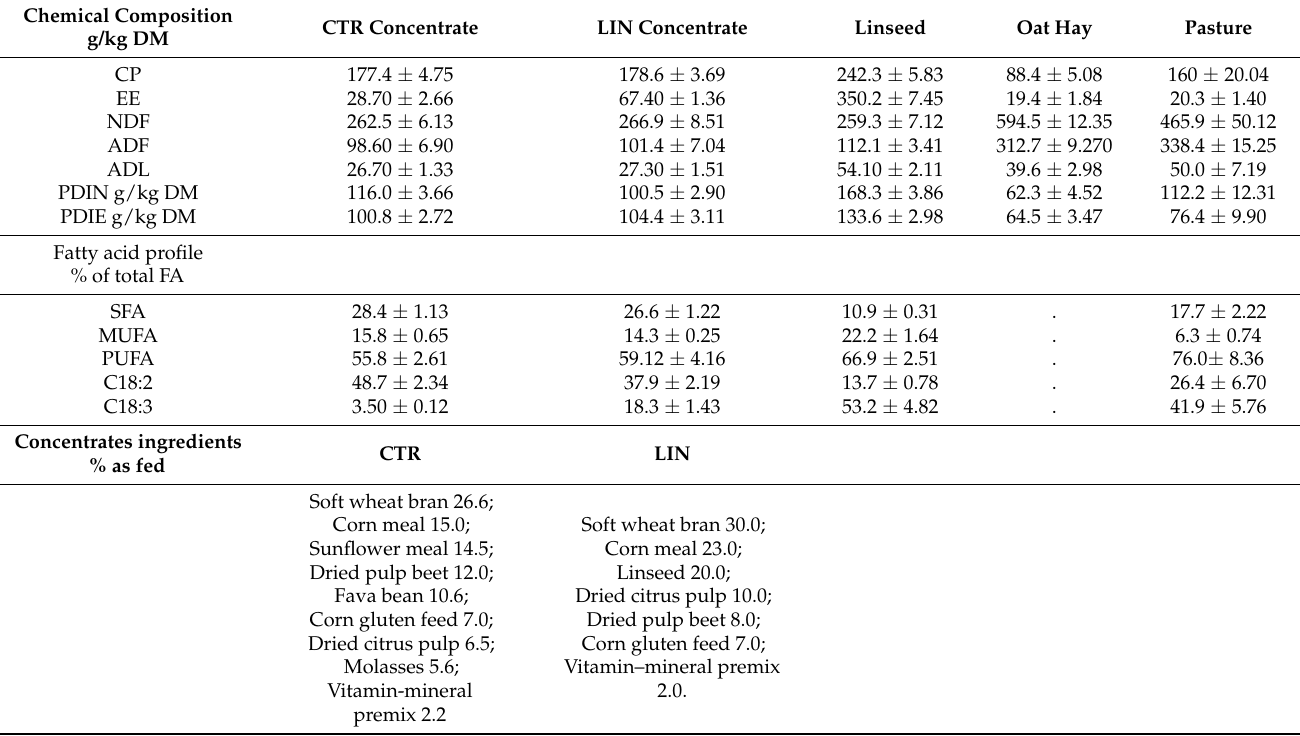
Table 1. Chemical composition and fatty acid profile (mean ± SD) of feeds administered to